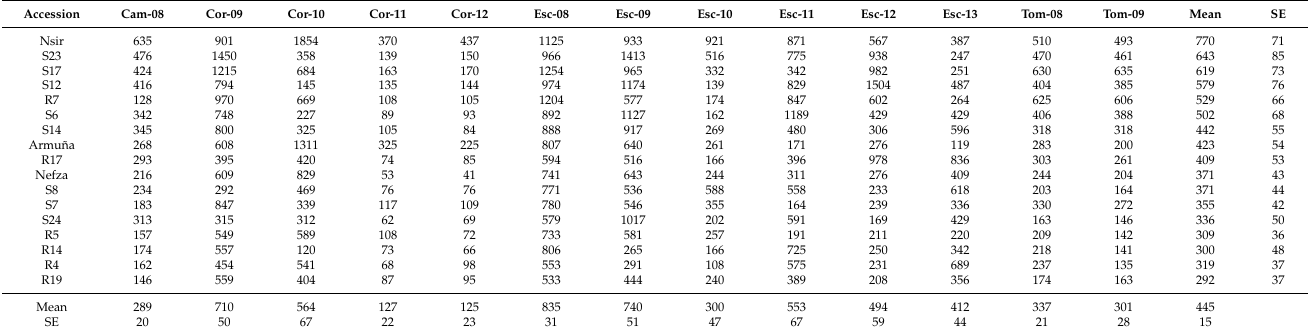
regional yields of 825 kg/ha in Castilla-la-Mancha and 717 kg/ha in Andalusia [26]. Table 4. Mean seed yield (kg/ha) of 17 lentil accessions grown at 13 location–year